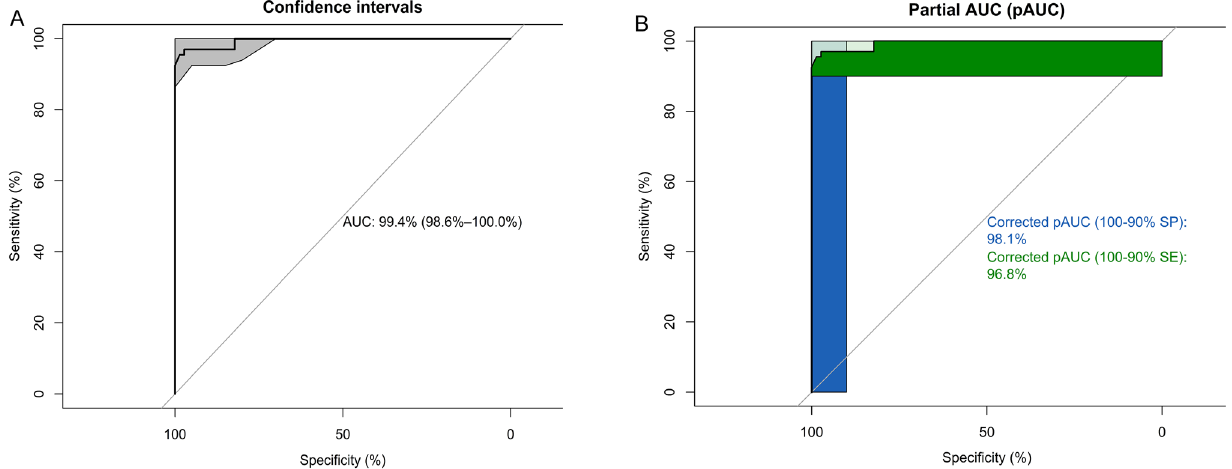
Figure 2. Statistical model performance of the random forest algorithm to diagnose breast cancer. Legends: ( A ) The discriminatory accuracy is expressed as AUC with the 95% confidence interval. The grey area is the 95% confidence intervals using bootstrap resampling for 2000 replicates. ( B ) The partial area under the receiver operating curve (pAUC). The blue area corresponds to the pAUC region between 90 and 100% for specificity (SP), and the green area corresponds to the pAUC region between 90 and 100% for sensitivity (SE). The corrected pAUCs are printed in the middle of the plot. Luminal Model